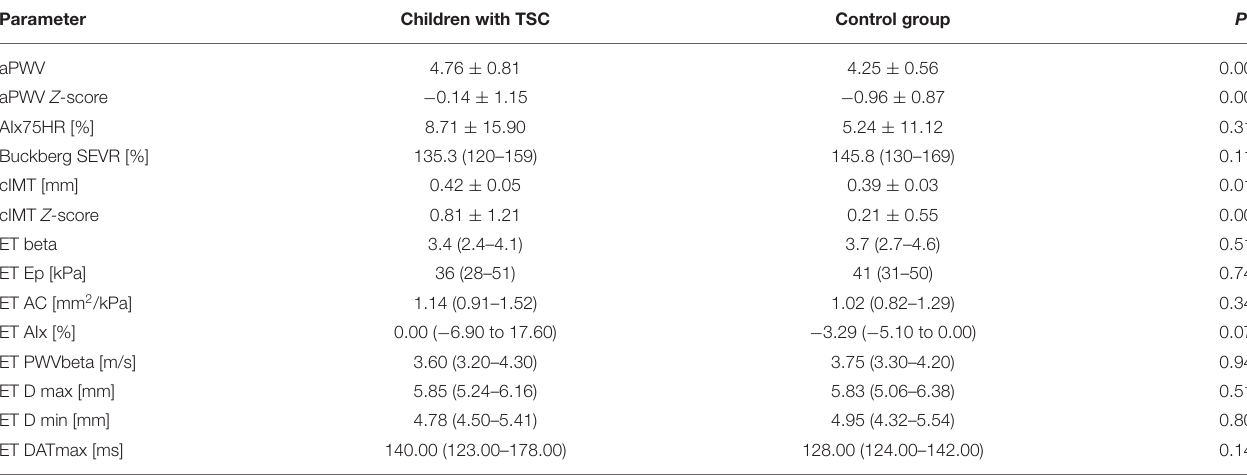
TABLE 3 | Parameters of arterial damage (early vascular aging) in children with tuberous sclerosis complex and in healthy children. Parameter Children with TSC Control